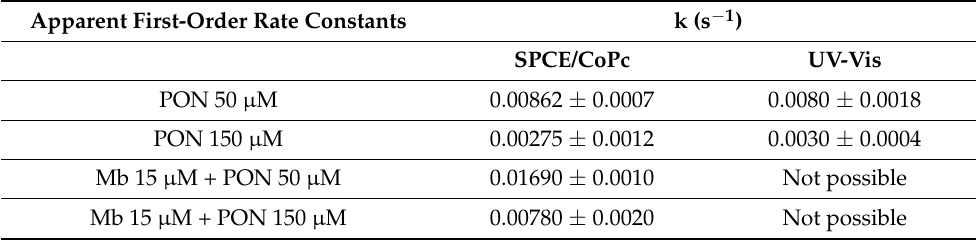
Table 4. Observed first-order decay rates constants for PON, in PBS pH 9 (0.1M), at 25 ◦ C, determined using the classical UV-Vis method at 302 nm and the FIA-EC method, using the SPCE/CoPc (Method B). Apparent First-Order Rate Constants